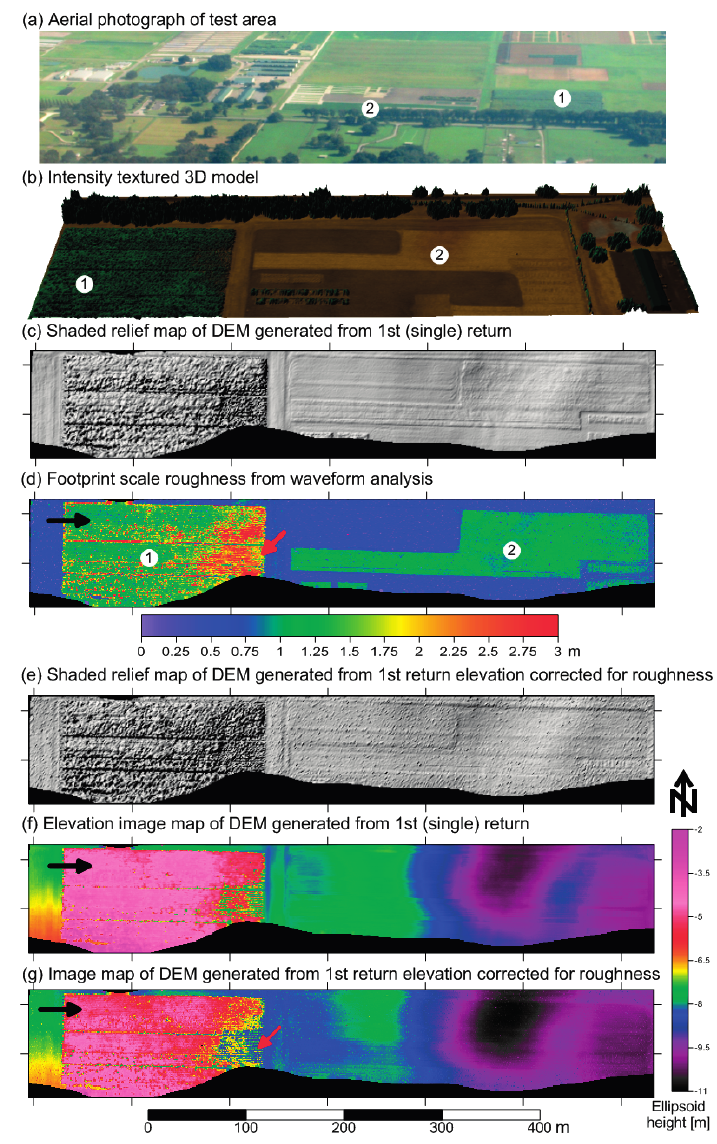
Figure 15. Experimental comparison of the capabilities of discrete and full waveform digitizing ALS systems to produce bare-earth data products from underneath low vegetation canopies. ( a ) Oblique aerial photo of the test area; ( b ) rendering of an intensity textured 3D model; ( c ) shaded relief map of DSM from discrete data; ( d ) image map of footprint-scale roughness derived from full waveform data; ( e ) shaded relief map of DSM from waveform corrected data; ( f ) elevation image map of DSM from discrete data; ( g ) elevation image map of DSM from from waveform corrected